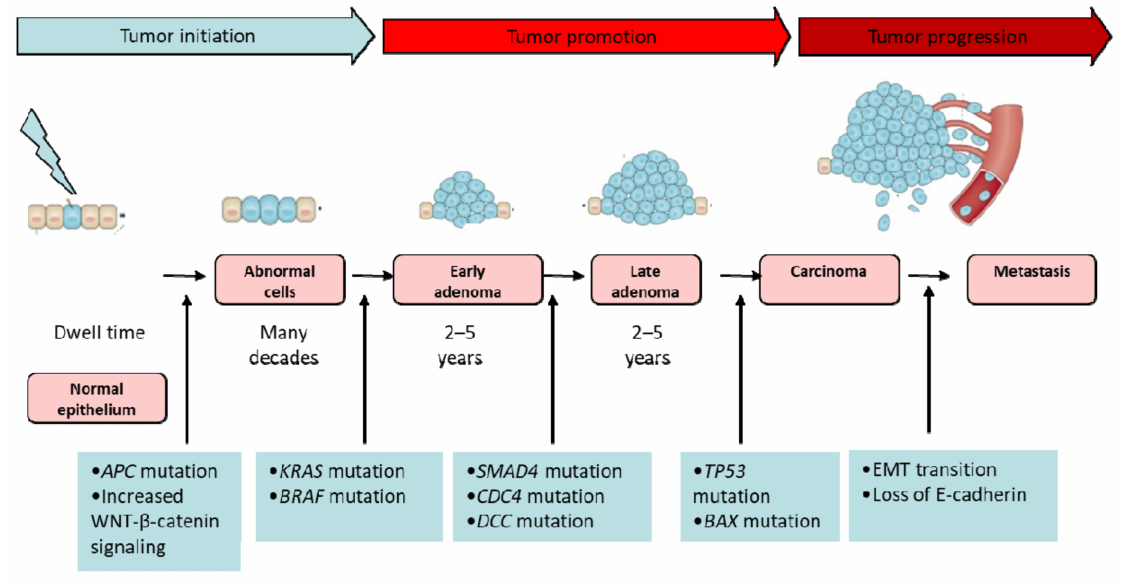
Figure 2. Mechanisms of colorectal